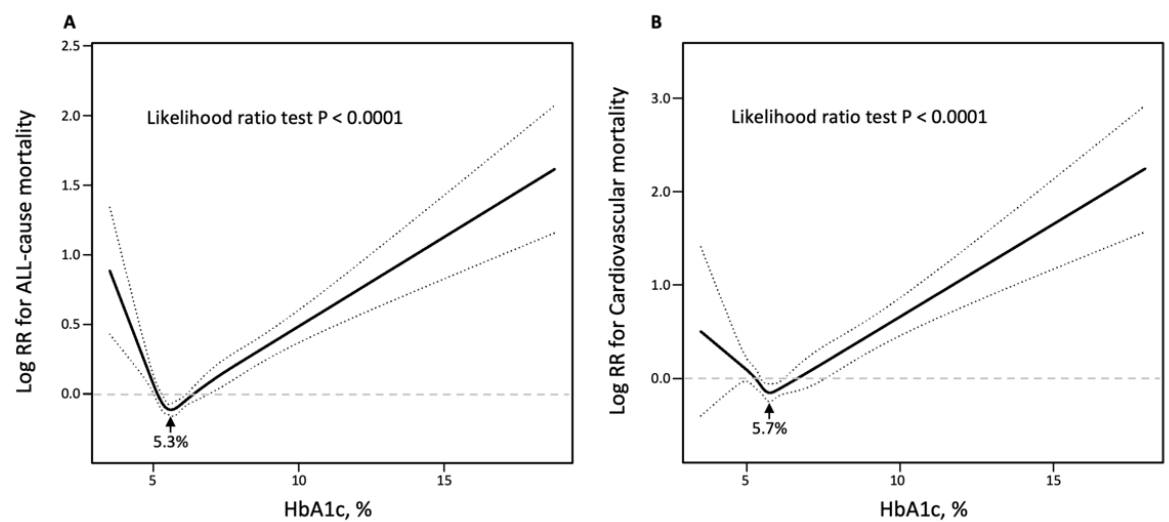
Figure 3. Restricted cubic spine models of HbA1c with all-cause ( A ) and cardiovascular ( B ) mortality in hypertension patients. HbA1c, glycated hemoglobin A1c. Restricted cubic spine models were adjusted for age, gender, race, education, body mass index, smoking, coronary heart disease, acute myocardial infarction, chronic heart failure, stroke, creatinine, hemoglobin, triglycerides, total cholesterol, high-density lipoprotein cholesterol, antihypertensive drugs, hypoglycemic agents, aspirin, clopidogrel, and statin.